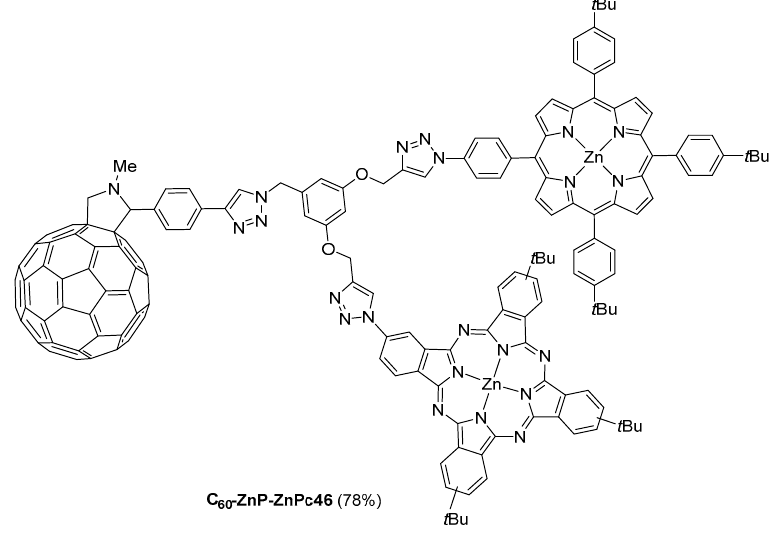
Figure 6. Structure of C 60 -ZnP-ZnPc46 triad.